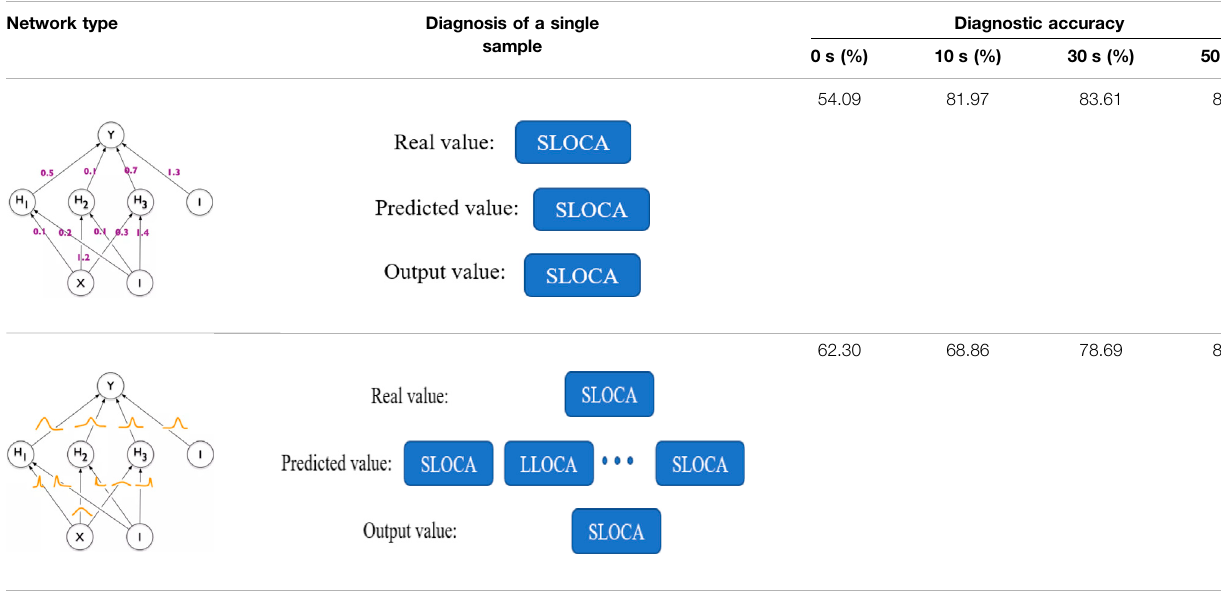
TABLE 6 | Comparison of BPNN and BNN results.